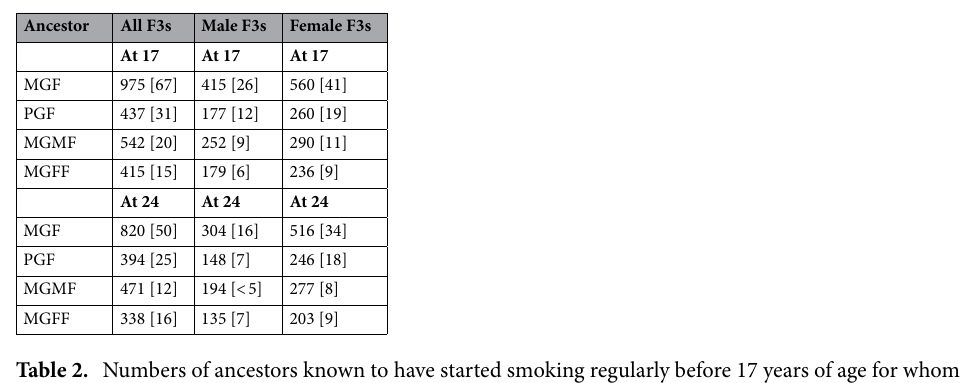
Table 2. Numbers of ancestors known to have started smoking regularly before 17 years of age for whom there are F3 measures of fat and lean mass [numbers who had started smoking < 13 years of age are in square